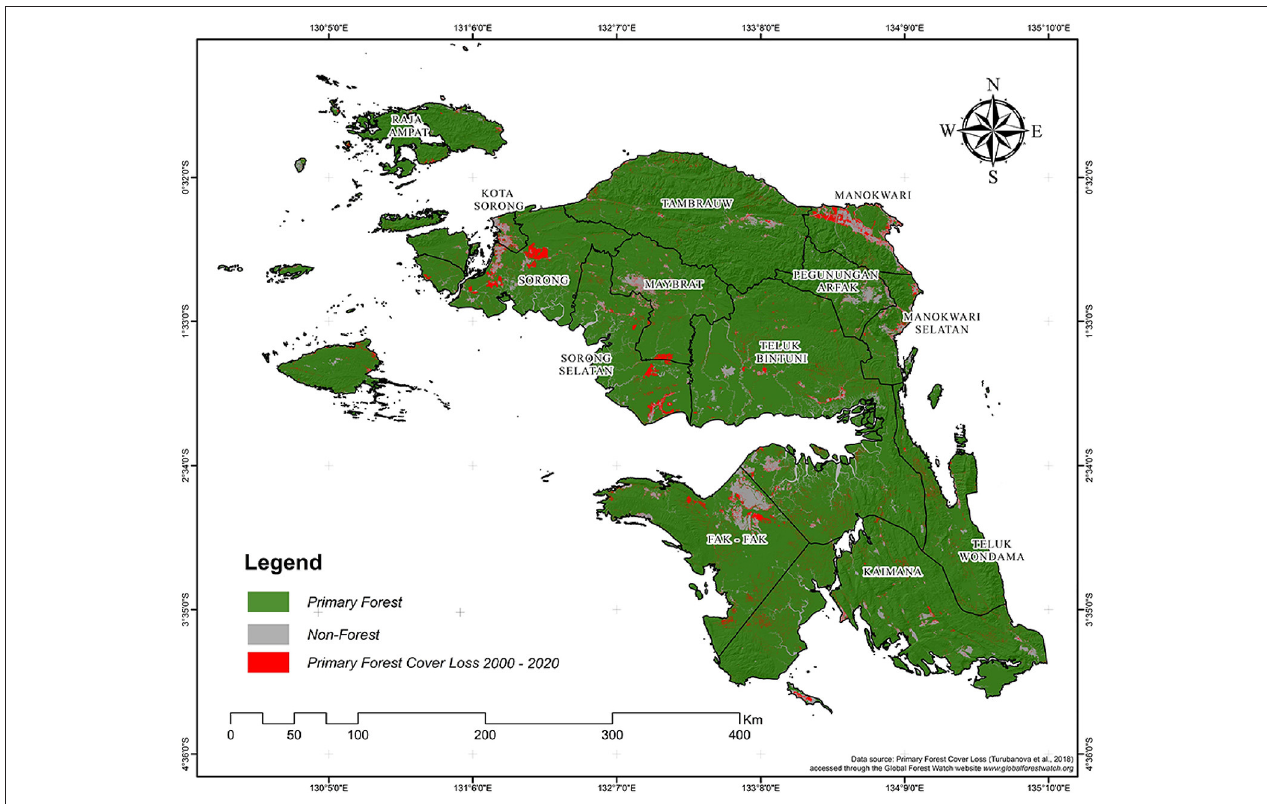
FIGURE 1 | Primary forest cover loss of West Papua Province 2000-2020 a . a Green color shows the primary forest cover in West Papua year 2020, covering 9.2 million hectares of land area, or about 89% of the Province; Red color represents the area of deforestation from 2000 to 2020, covering about 205 thousand hectares cumulatively; The data was based on Turubanova et al. (2018), accessed through the Global Forest Watch website. There is another deforestation data provided by the Ministry of Environment and Forestry (MOEF) in https://geoportal.menlhk.go.id/ which show different deforestation rate. However, both datasets suggest that there has been deforestation in West Papua Province during the same period. This paper uses Turubanova et al. (2018) due to the availability and accessibility of the spatial